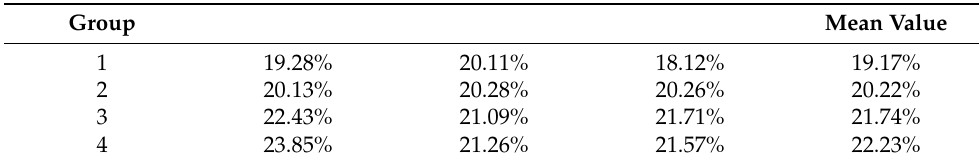
Table 9. Surface sulfur content of ore